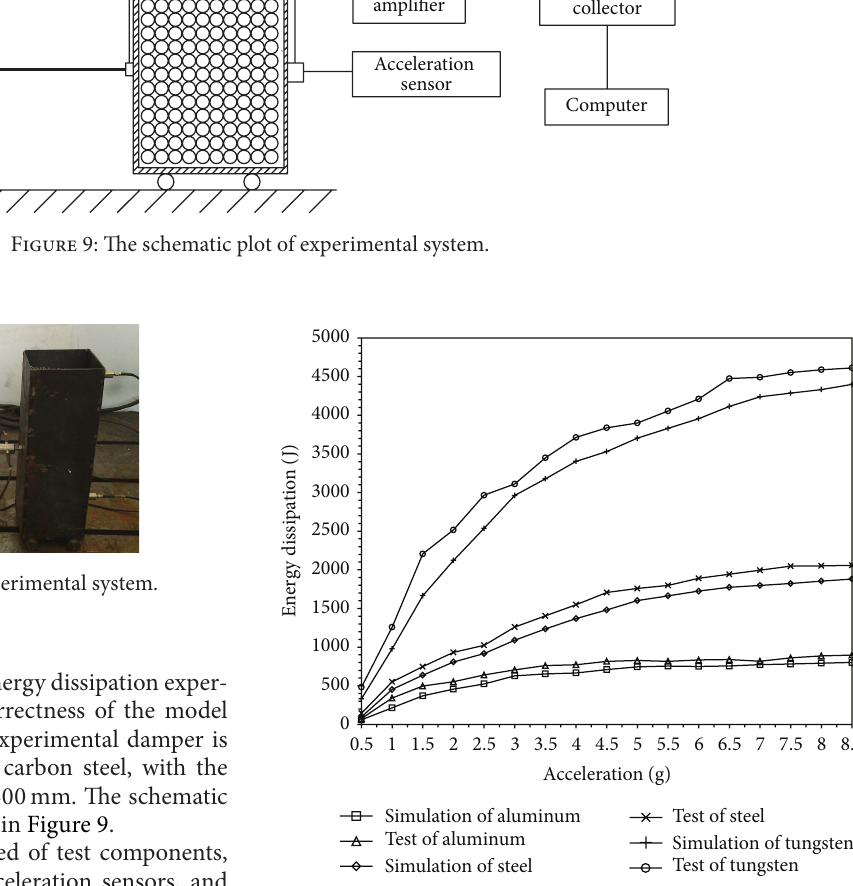
Figure 11: The energy dissipation results for the simulation and